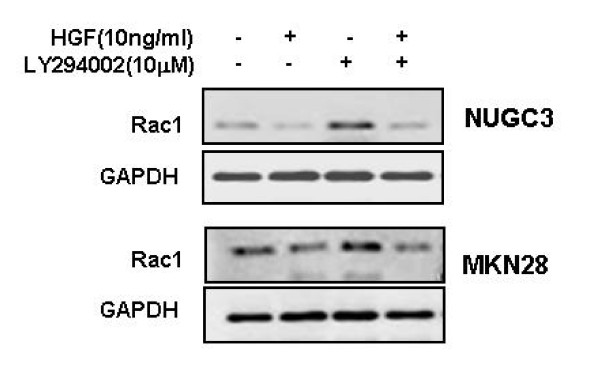
Effects of HGF and LY 294002 on Rac-1 activation. Serum-starved cells was pretreated with or without LY (10 μM) for 30 min and then treated with or without HGF. After incubation for 15 min, the cells were collected, washed, and then sonicated. Cell lysates were immunoprecipitated with PAK-1 PBD and Rac-1 activation was measured by Western blotting with a Rac-1 antibody. Representative data from three independent experiments were shown.